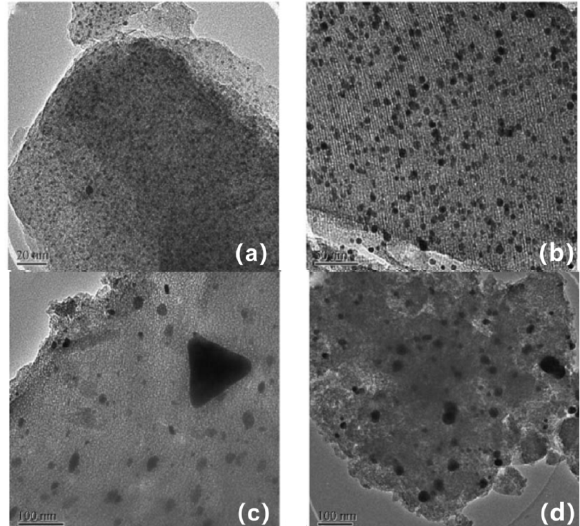
Figure 6. TEM images of MCM-41 modified with 3-aminopropyltriethoxysilane (APTS), − adsorbed, and reduced by NaBH4 ( a ) uncalcined, ( b ) calcined at 560 °C, ( c ) then AuCl 4 and ( d ) without modification with APTS. Reproduced with permission from